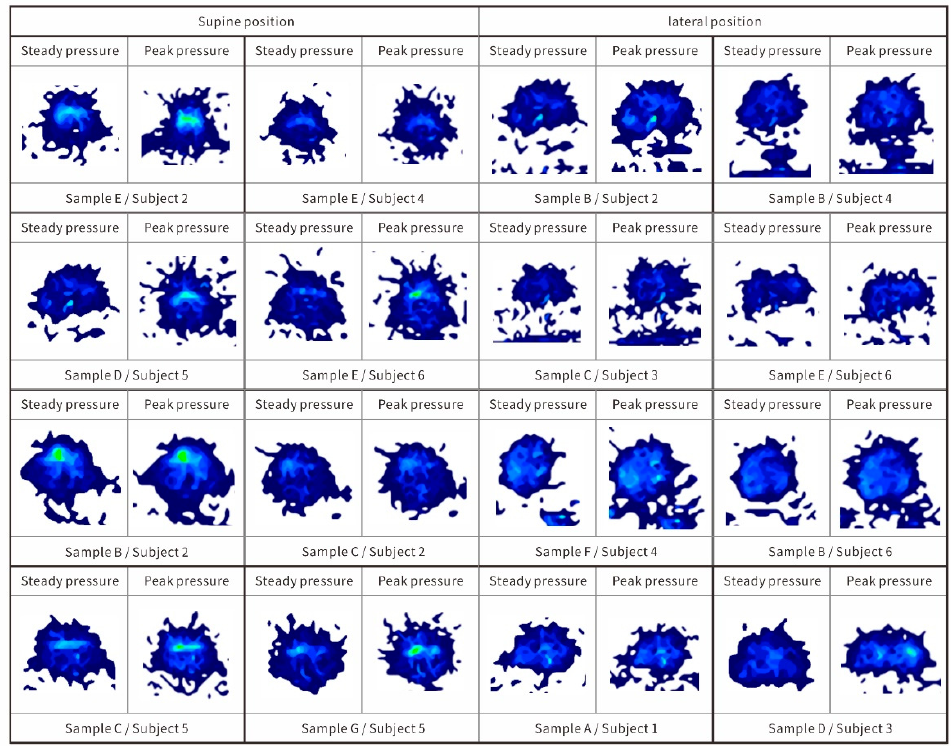
Figure 2. The highest comfort evaluation of the eight groups of supine and lateral pressure distribution map.